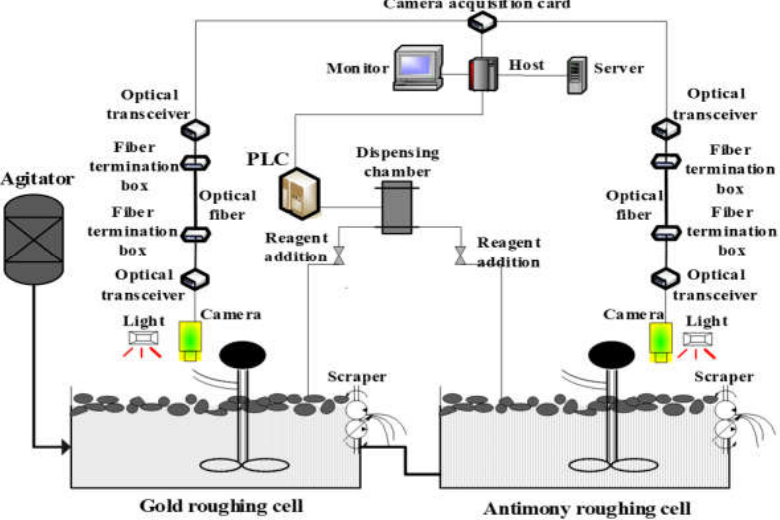
Figure 7. Hardware structure of froth image monitoring system.